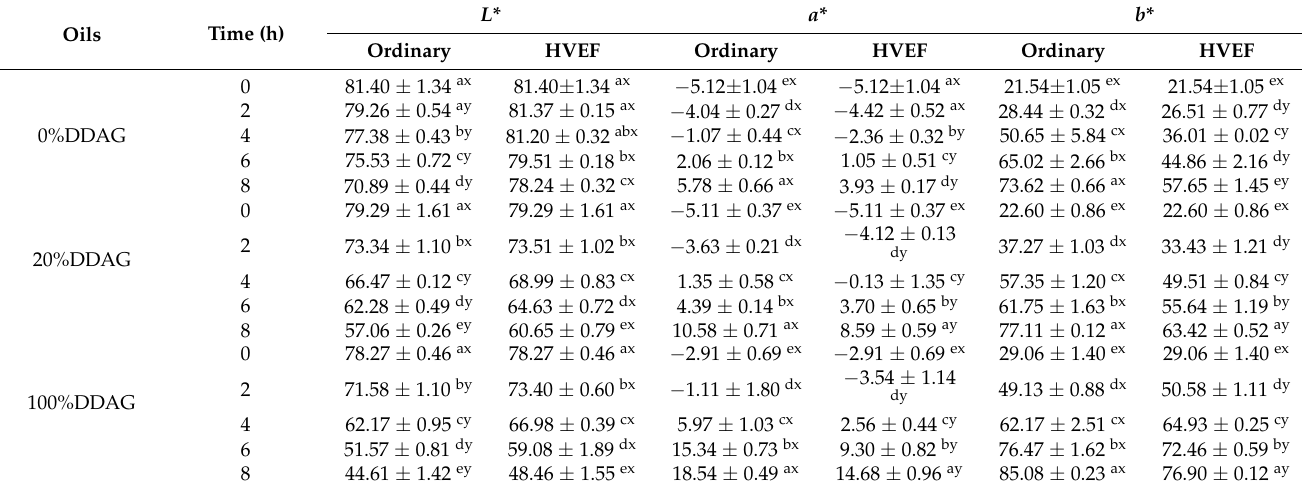
Table 2. The color of different DDAG concentrations of duck oils during ordinary heating and HVEF heating at 180 °C.